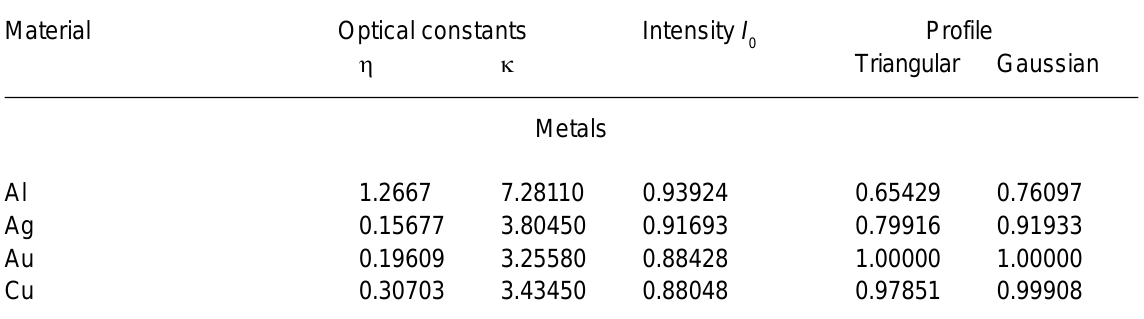
and membership 0